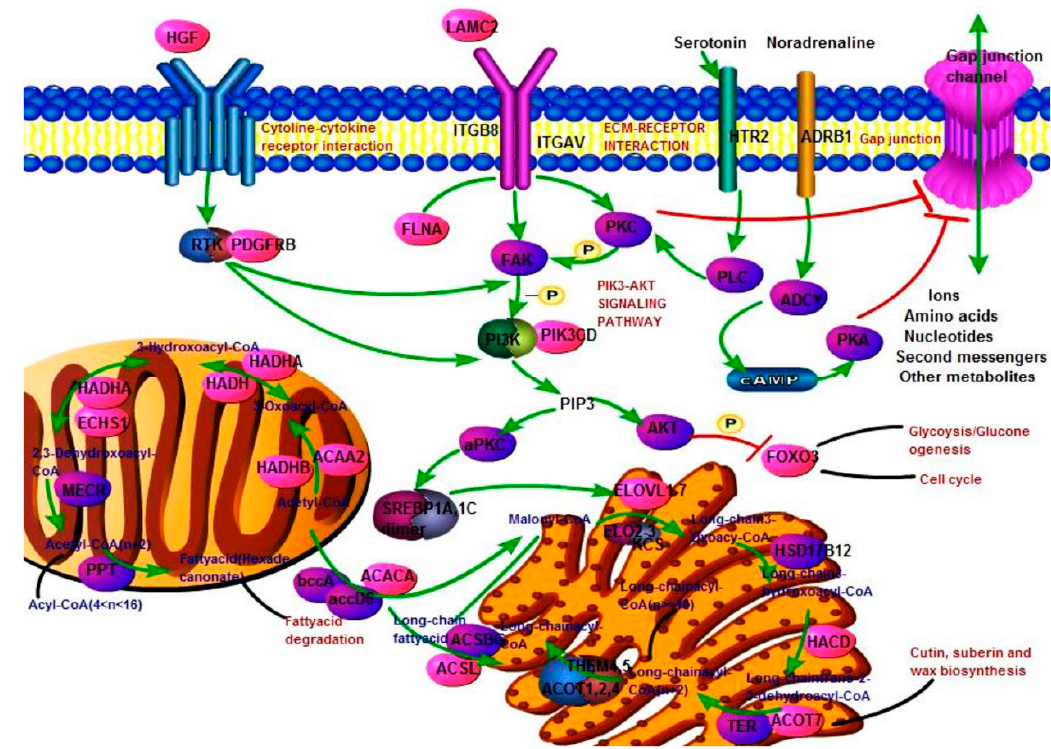
Figure 7. Fatty acid biosynthesis function network. The red molecule and other color molecule respectively represent DEGs and unidentified genes. The green line and the black line represent direct connection and indirect connection. The blue and red letters represent chemical molecules and pathways.